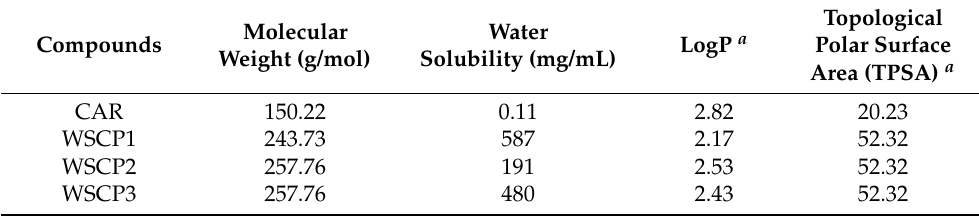
Table 1. Molecular properties of the CAR and the WSCPs.